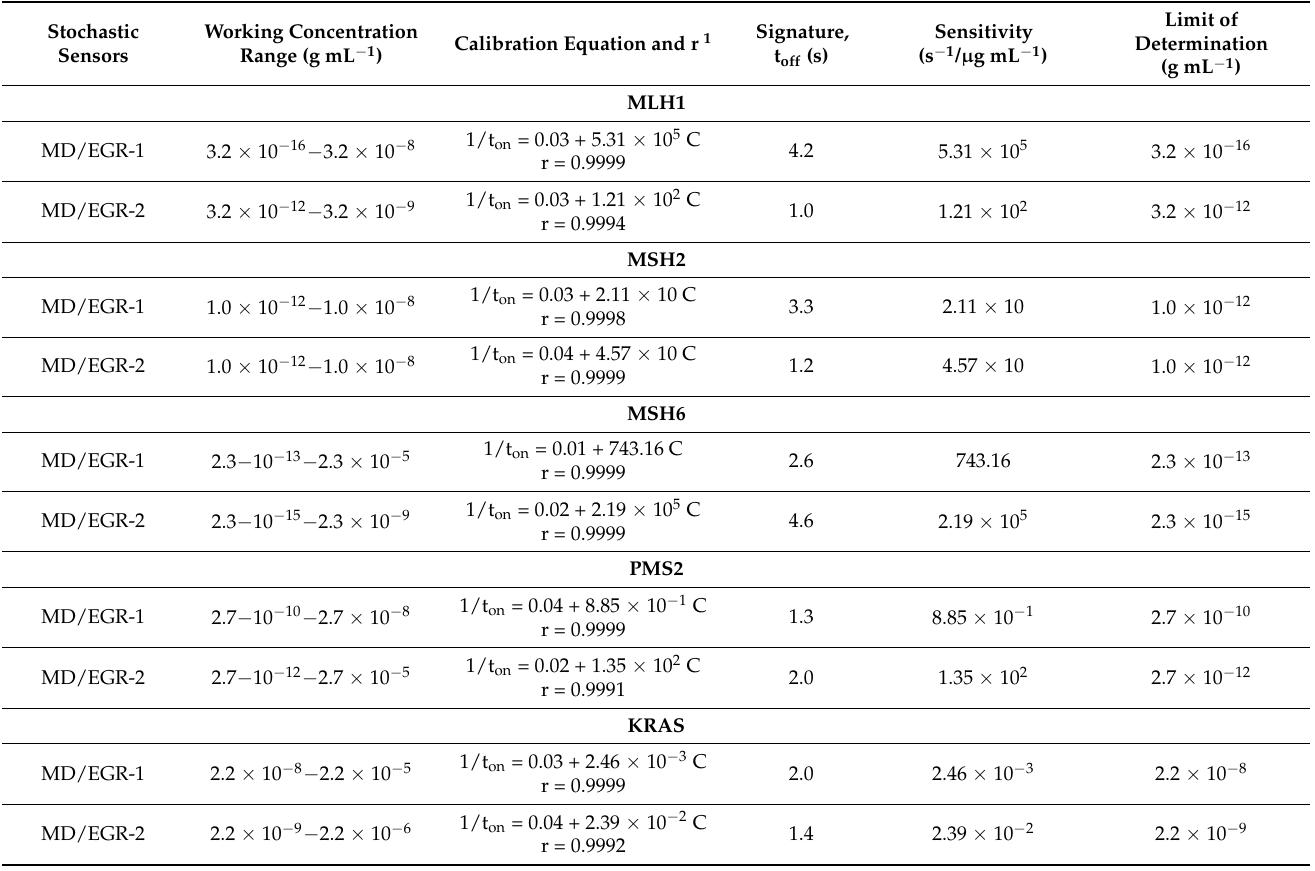
Table 1. Performance characteristics of the stochastic sensors for the assay of MLH1, MSH2, MSH6, PMS2 and